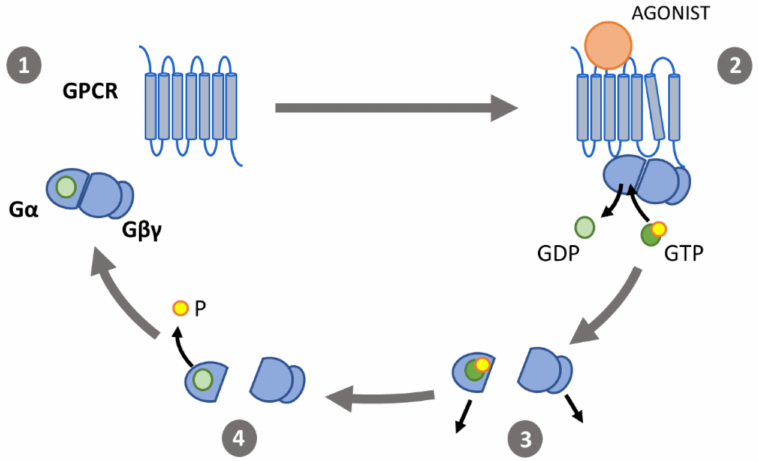
Figure 2. The G protein activation cycle: ( 1 ) in its inactive state, the α -subunit (G α ) binds guanosine diphosphate (GDP) and forms a heterotrimeric G protein complex with the β - and γ -subunits (G βγ ). ( 2 ) Binding of an agonist to a G-protein coupled receptor (GPCR) induces conformational changes. The outward movement of transmembrane helix 6 enables interaction of the GPCR with the heterotrimeric G proteins, catalyzing the exchange of GDP for GTP. ( 3 ) G α and G βγ then dissociate and interact with effectors. ( 4 ) G α -induced hydrolyzation of GTP to GDP causes the G protein subunits to associate and return to their inactive